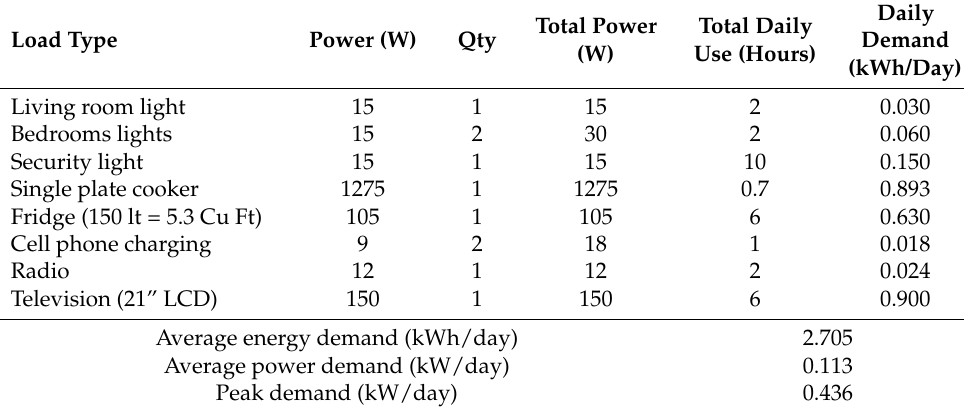
Table 4. Shack-24sqm daily load profile (a 24 sqm unit segmented into 2 rooms housing a family of 4).